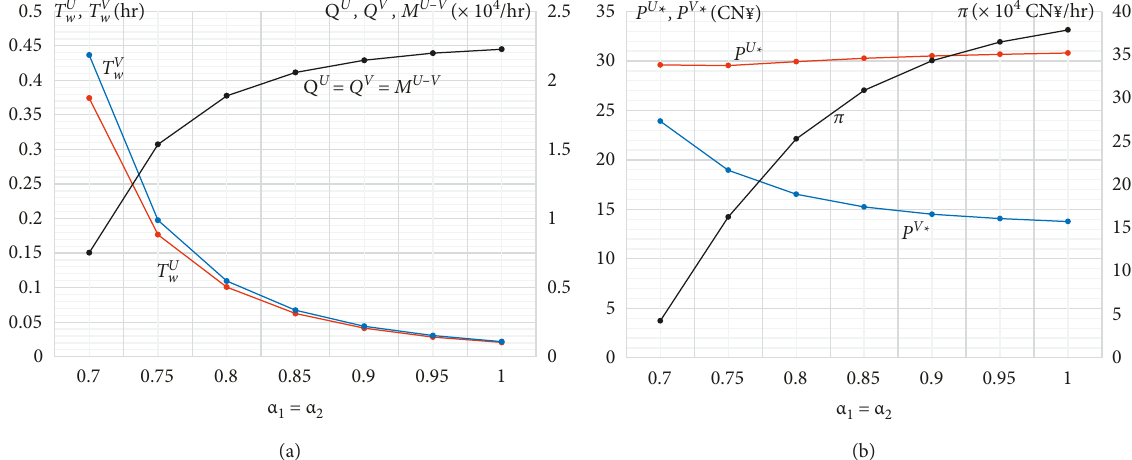
Figure 8: Sensitivity analysis with respect to platform matching elasticities. (a) Changes in T U P V ∗ , and π .